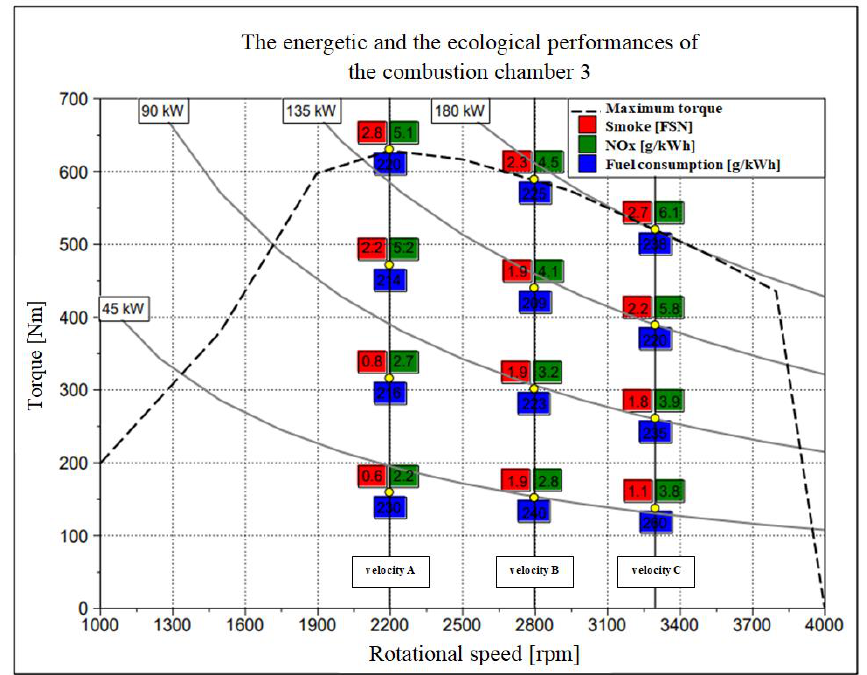
Figure 31. The energetic and the ecological parameters of the engine equipped with the combustion chamber 3 (toroidal shape).